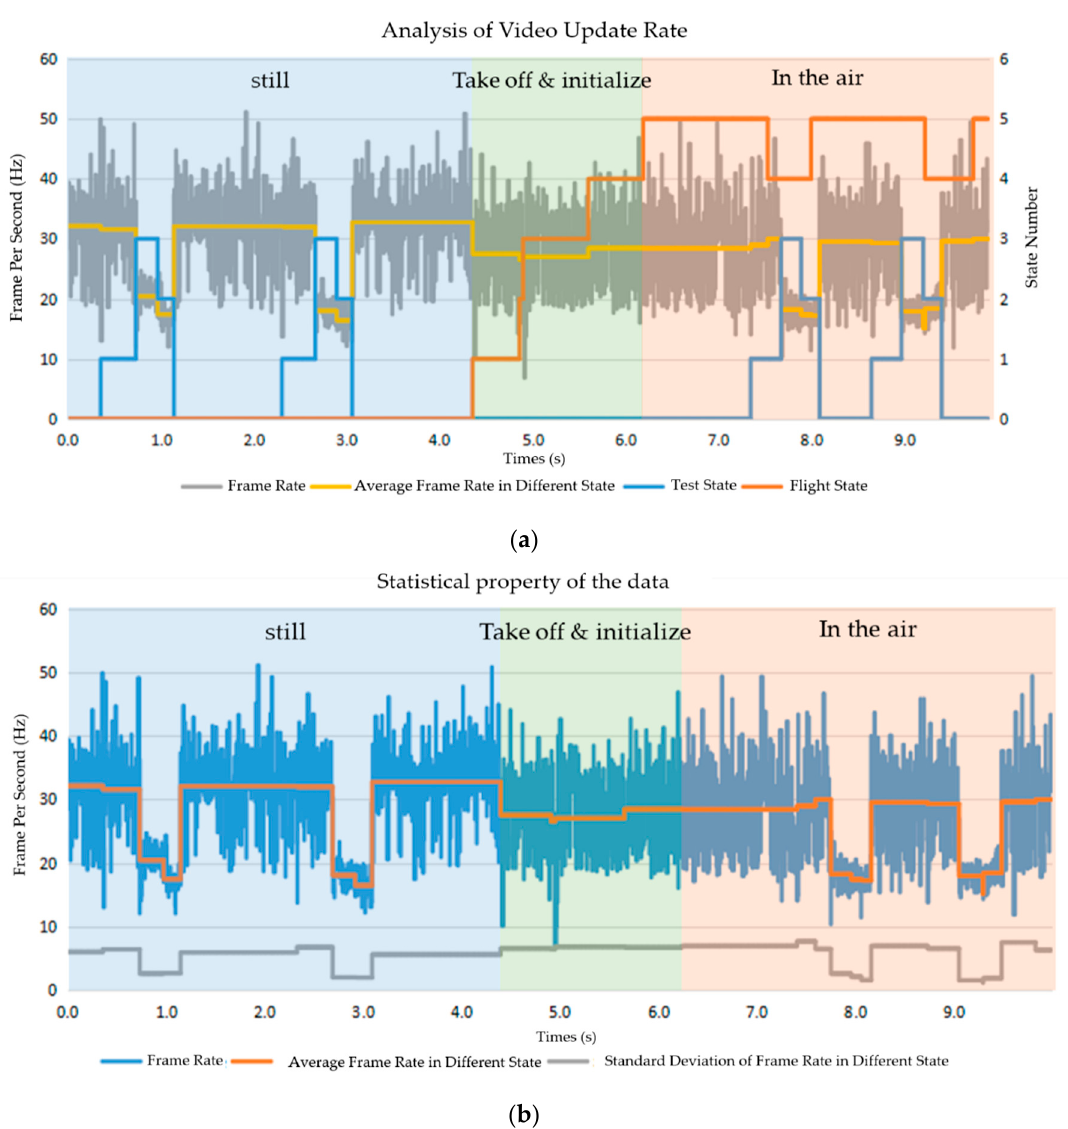
Figure 13. Video update rate analysis: ( a ) Analysis of video update rate; ( b ) Statistical properties of the data.